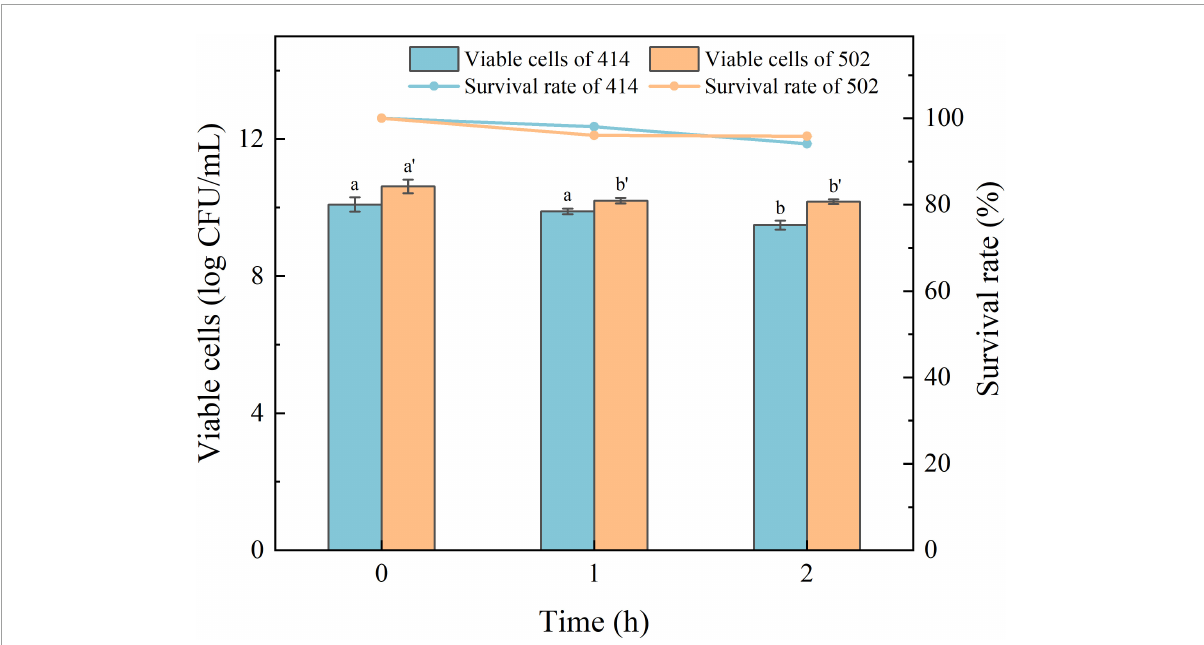
FIGURE4 The survival rate of WFC 414 and WFC 502 cells incubated in simulated gastric juice for 1 and 2 h. Different letters (a, b or a’, b’) indicate significant differences at p < 0.05. Error bars show standard deviation.